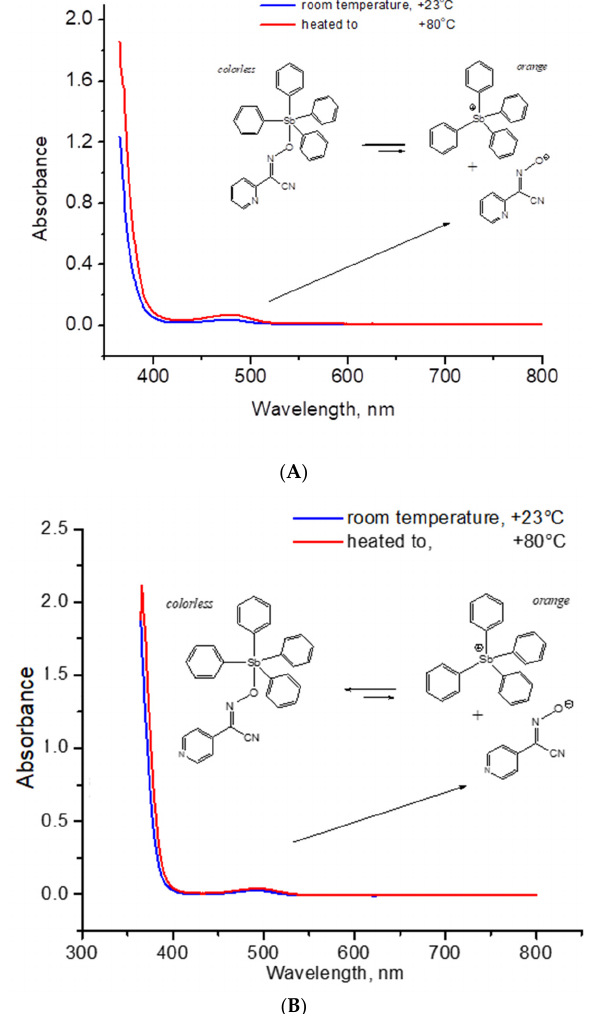
Figure 7. ( A ) An overlay of fragments of the UV/visible spectra of SbPh 4 (2PCO) in DMSO at two terminal temperatures; ( B ) an overlay of fragments of the UV/visible spectra of SbPh 4 (4PCO) in propionitrile at the same two terminal temperatures.